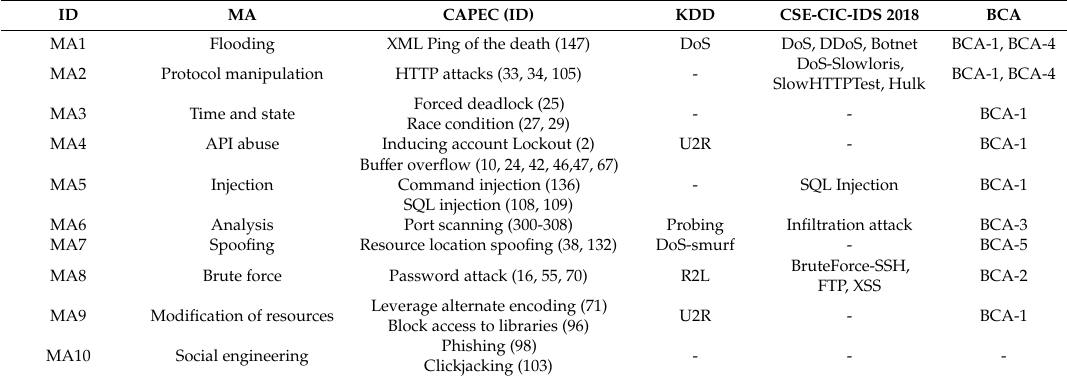
Table 1. Mapping of MAs and BCAs through analyzing